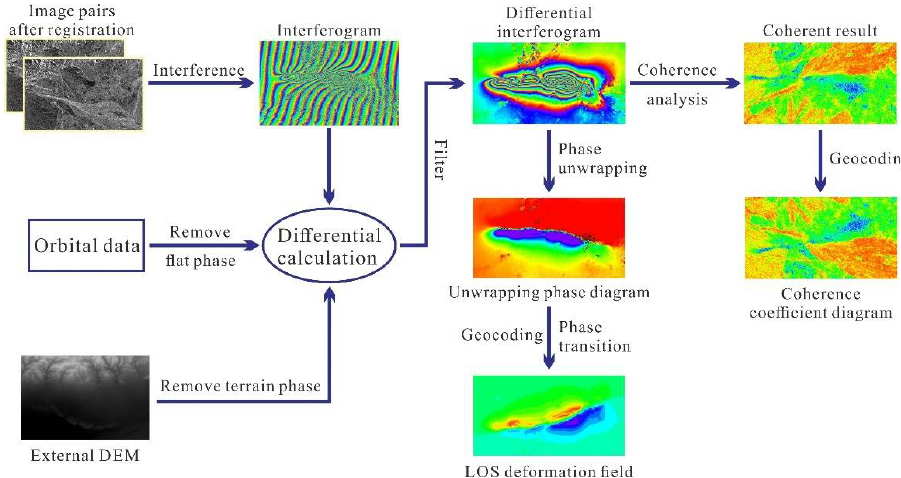
Figure 3. Basic steps of DInSAR.